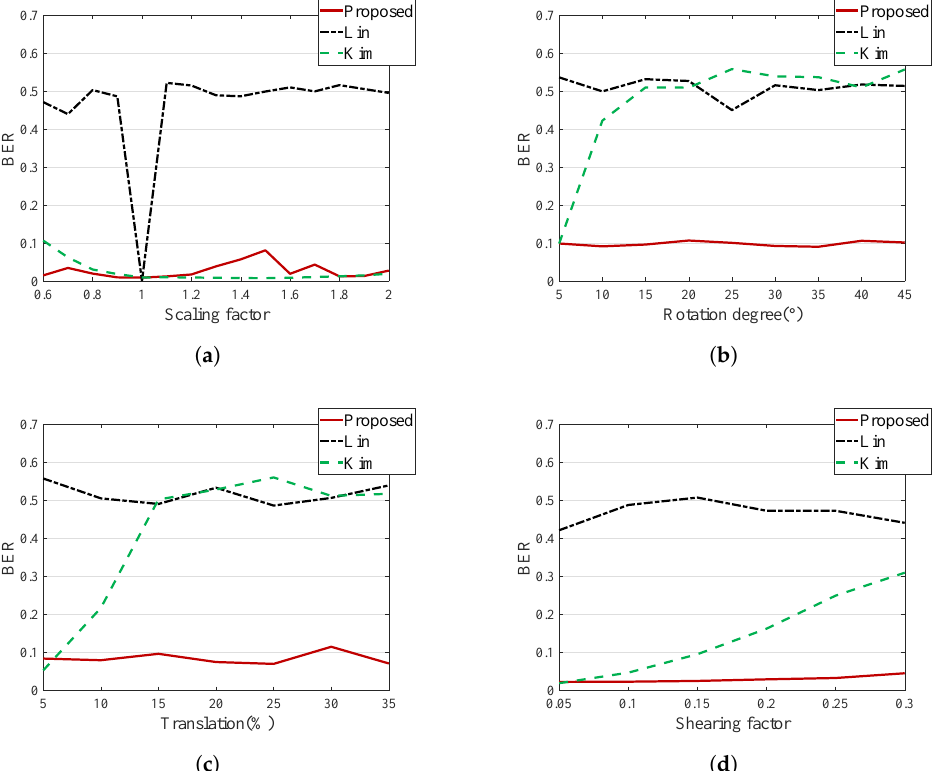
Figure 14. Average BER for geometric distortion. This experiment was conducted on the right image. ( a ) Image size scaling; ( b ) image rotation; ( c ) image translation; ( d ) image